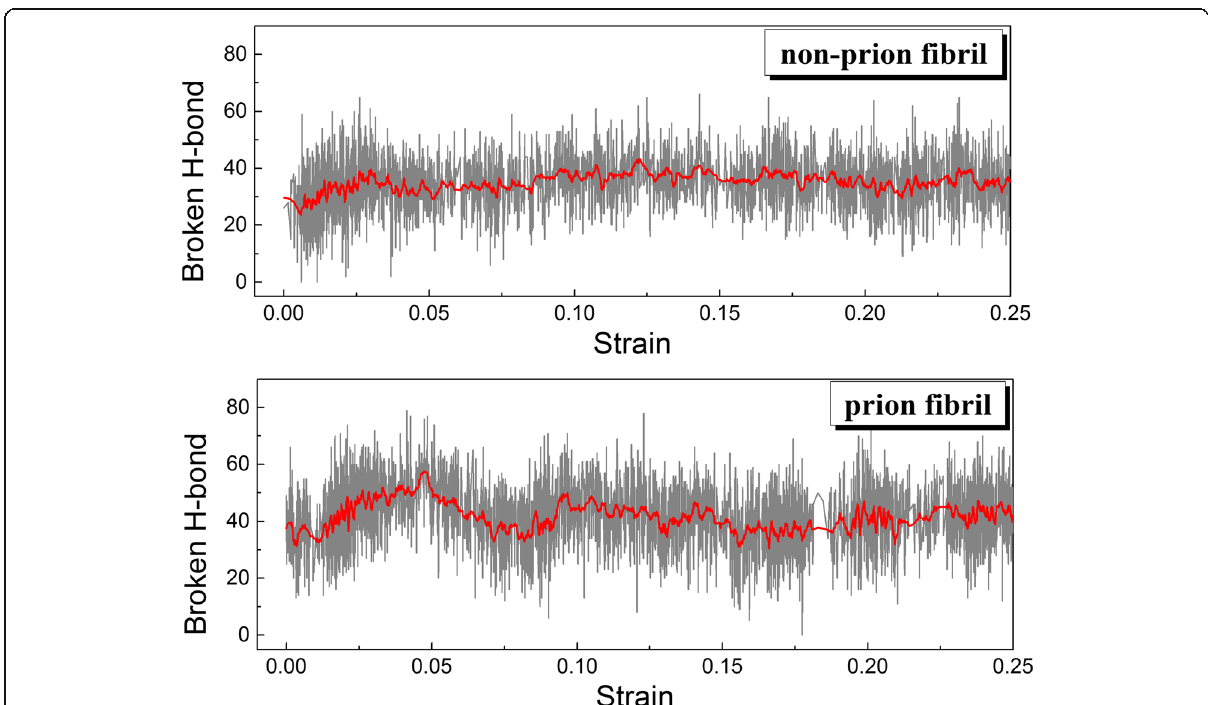
Fig. 5 The number of ruptured hydrogen bonds for prion and non-prion fibrils during their deformation